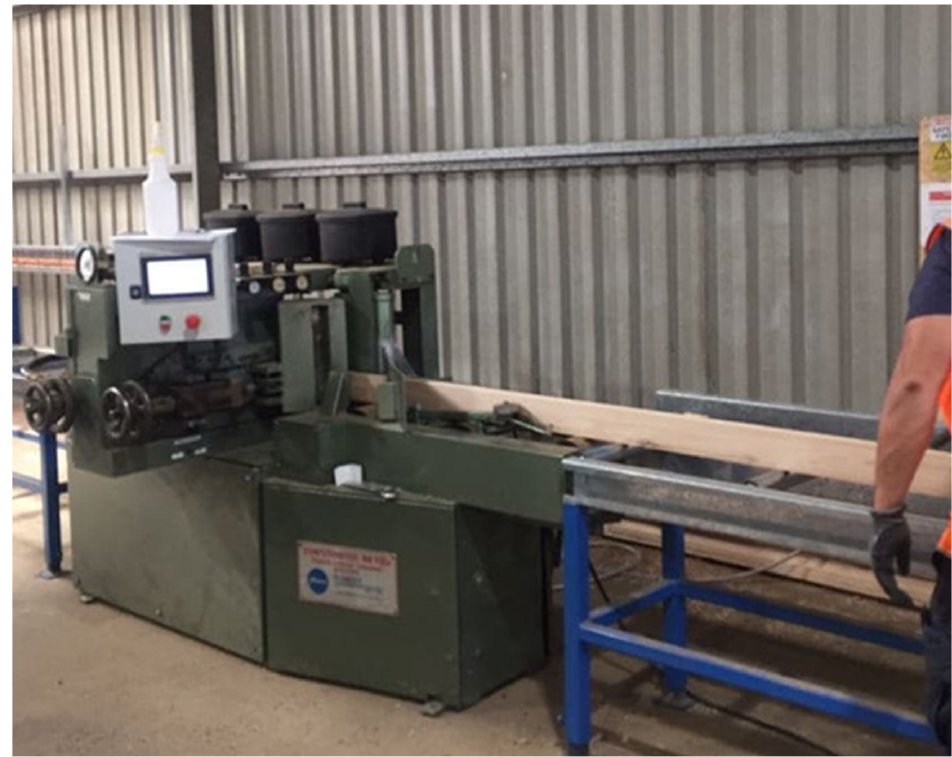
Figure 4. Machine stress grading of the timber boards .